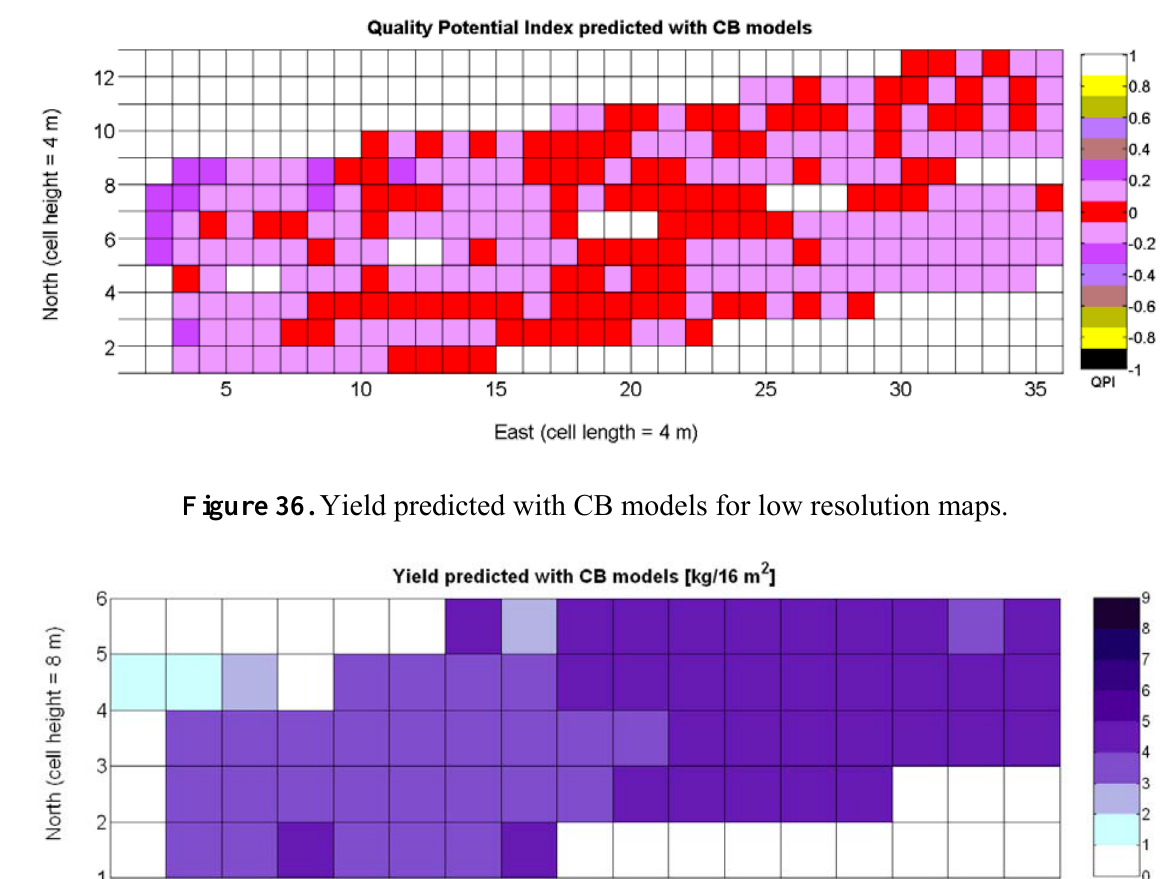
Figure 35. Quality Potential Index QPI predicted with CB models for high resolution maps.